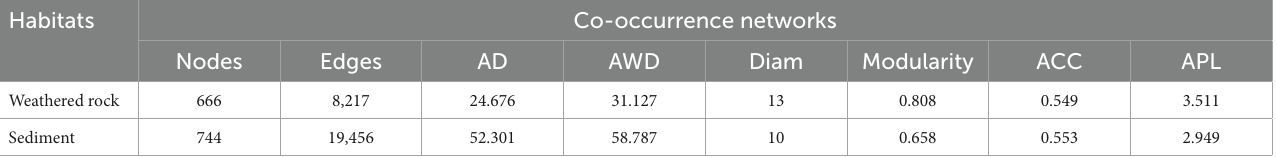
TABLE 2 Topological indices of co-occurrence networks in the Chang Cave, Hubei province, central China.